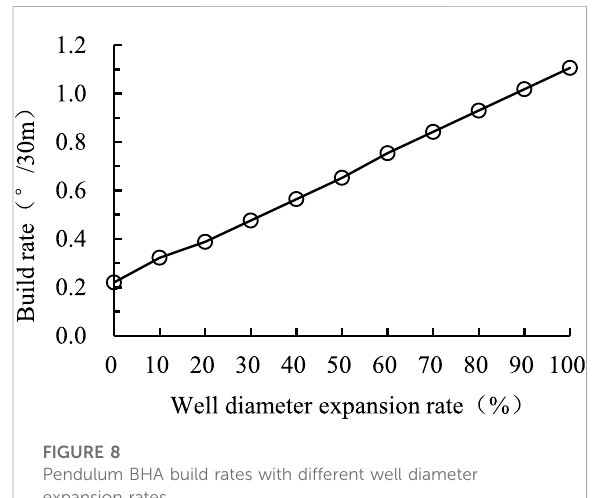
FIGURE 8 Pendulum BHA build rates with different well diameter expansion rates.